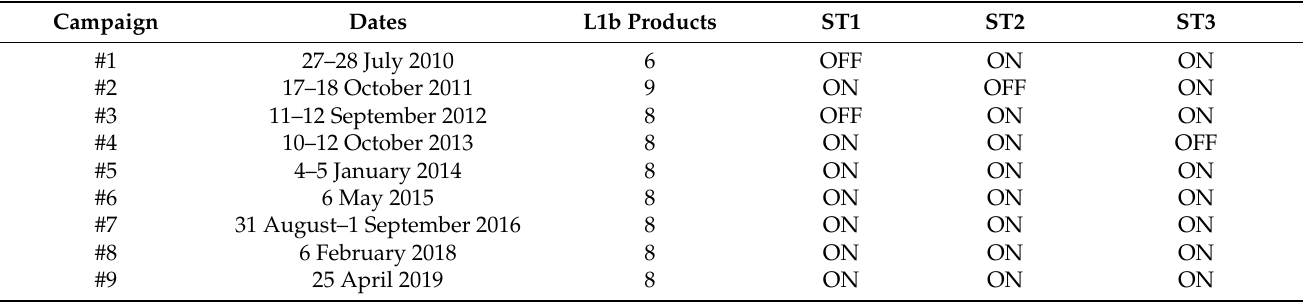
Table 1. Interferometer calibration